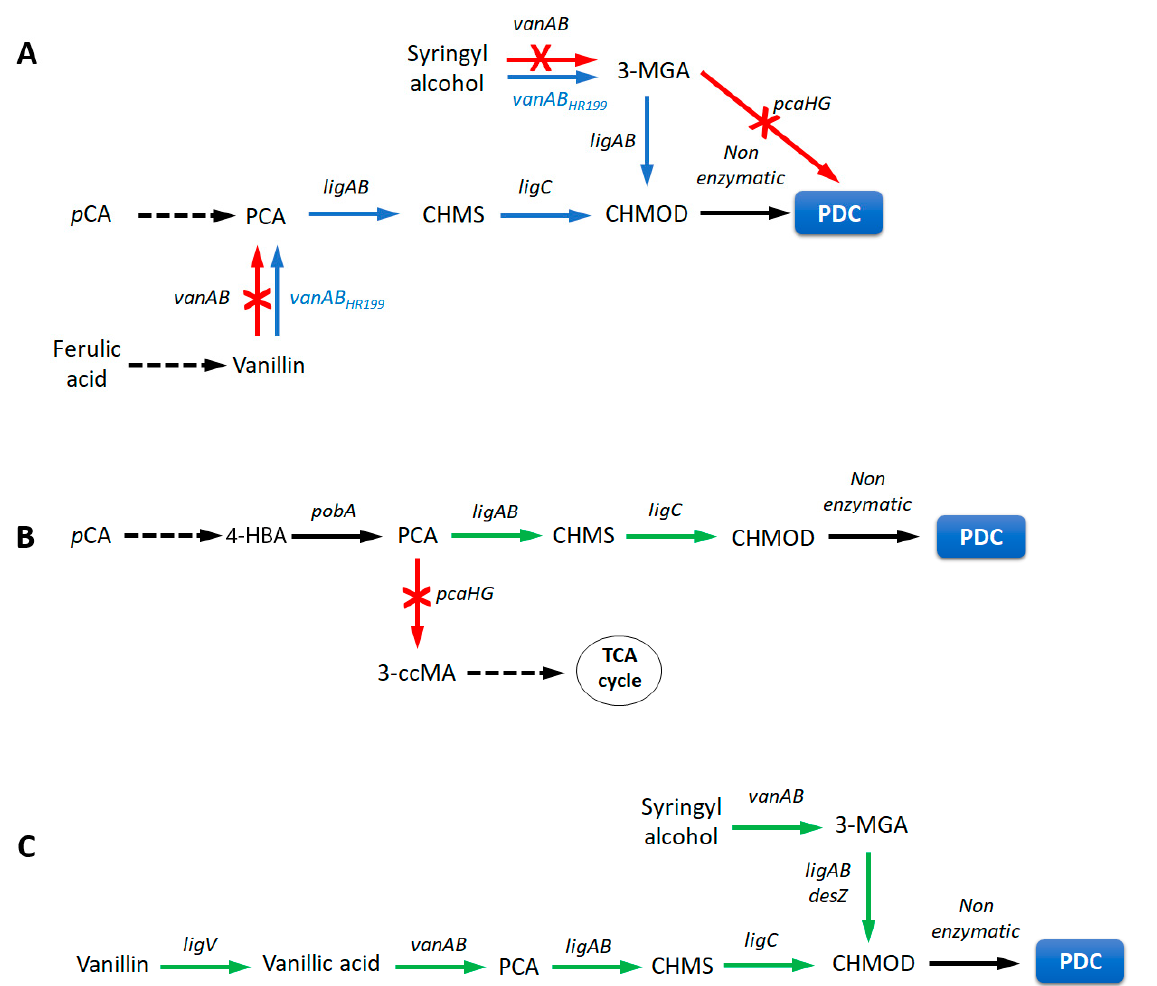
Figure 7. Scheme of PDC production from engineered ( A , B ) P. putida KT2440 [117,118] and ( C ) P. putida PDH [111]. Encoding genes: pcaHG, PCA 3,4-dioxygenase ; vanAB, vanillate demethylase ; ligAB, PCA 4,5-dioxygenase ; ligC, CHMS dehydrogenase ; pobA, p- hydroxybenzoate hydroxylase ; ligV, vanillin dehydrogenase ; desZ, 3 -O- methylgallate dioxygenase ; pCA , p- coumaric acid ; PCA, protocatechuic acid ; CHMS , 4-carboxy-2-hydroxy-cis,cis-muconate 6-semialdehyde ; CHMOD , 4- carboxy-2-hydroxy-6-methyoxy-6-oxohexa-2,4-dienoate ; 3-MGA, 3-methoxygallate ; 4-HBA, 4-hy- droxybenzoic acid ; 3ccMA, 3-carboxy-ccMA . Black arrows show the endogenous pathway; green arrows show overexpressed pathways; blue arrows show chromosomal inserted pathways; red crossed arrows identify deleted pathways; dashed arrows show additional multi-step pathways.